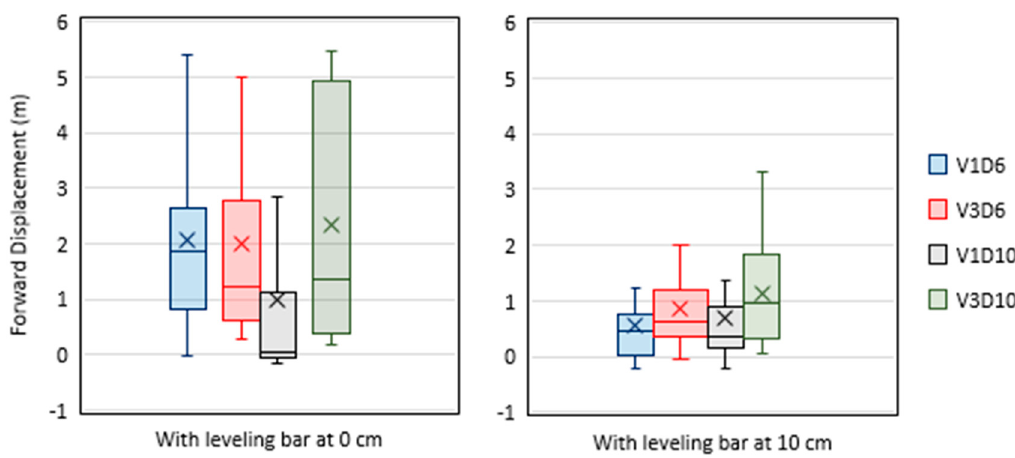
Figure 5. Average trackers forward movement at different working conditions where V1 and V3 refer to forward speed of 1 and 3 km/h. Also, D6 and D10 refer to working depth of 0.06 and 0.1 m.